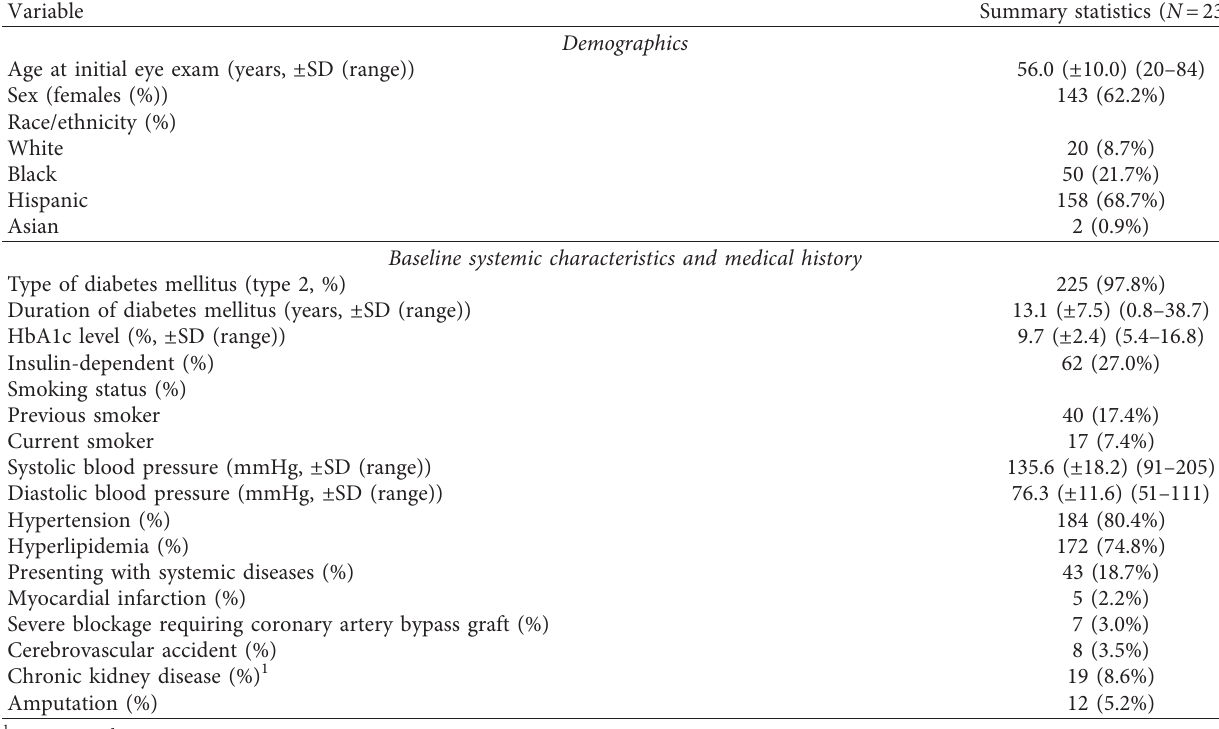
Table 2: Summary of demographics and medical